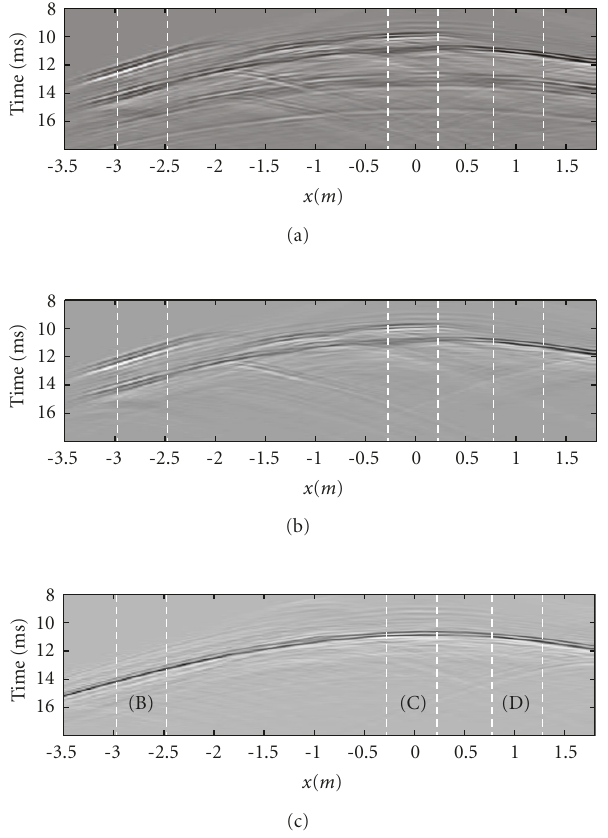
Figure 7: Demigrated impulse responses at z = 1 . 5 m used for the ATFs, (a) configuration (1), (b) configuration (2), and (c) configu- ration (3). The vertical lines indicate the groups of eleven impulse responses used for cases (B), (C), and (D).